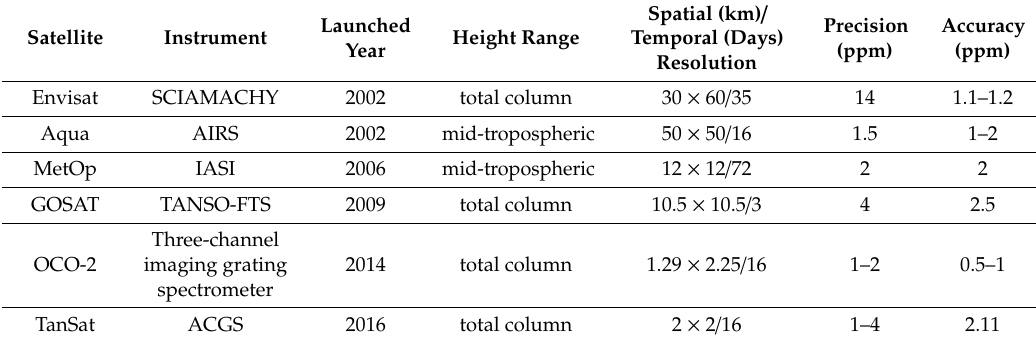
Table 1. Specification of satellite instruments for Carbon dioxide (CO 2 )